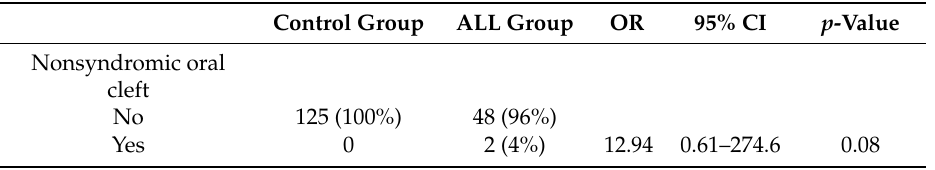
Table 2. Frequency of nonsyndromic oral cleft in first-degree relatives of patients with acute lymphoblastic leukemia